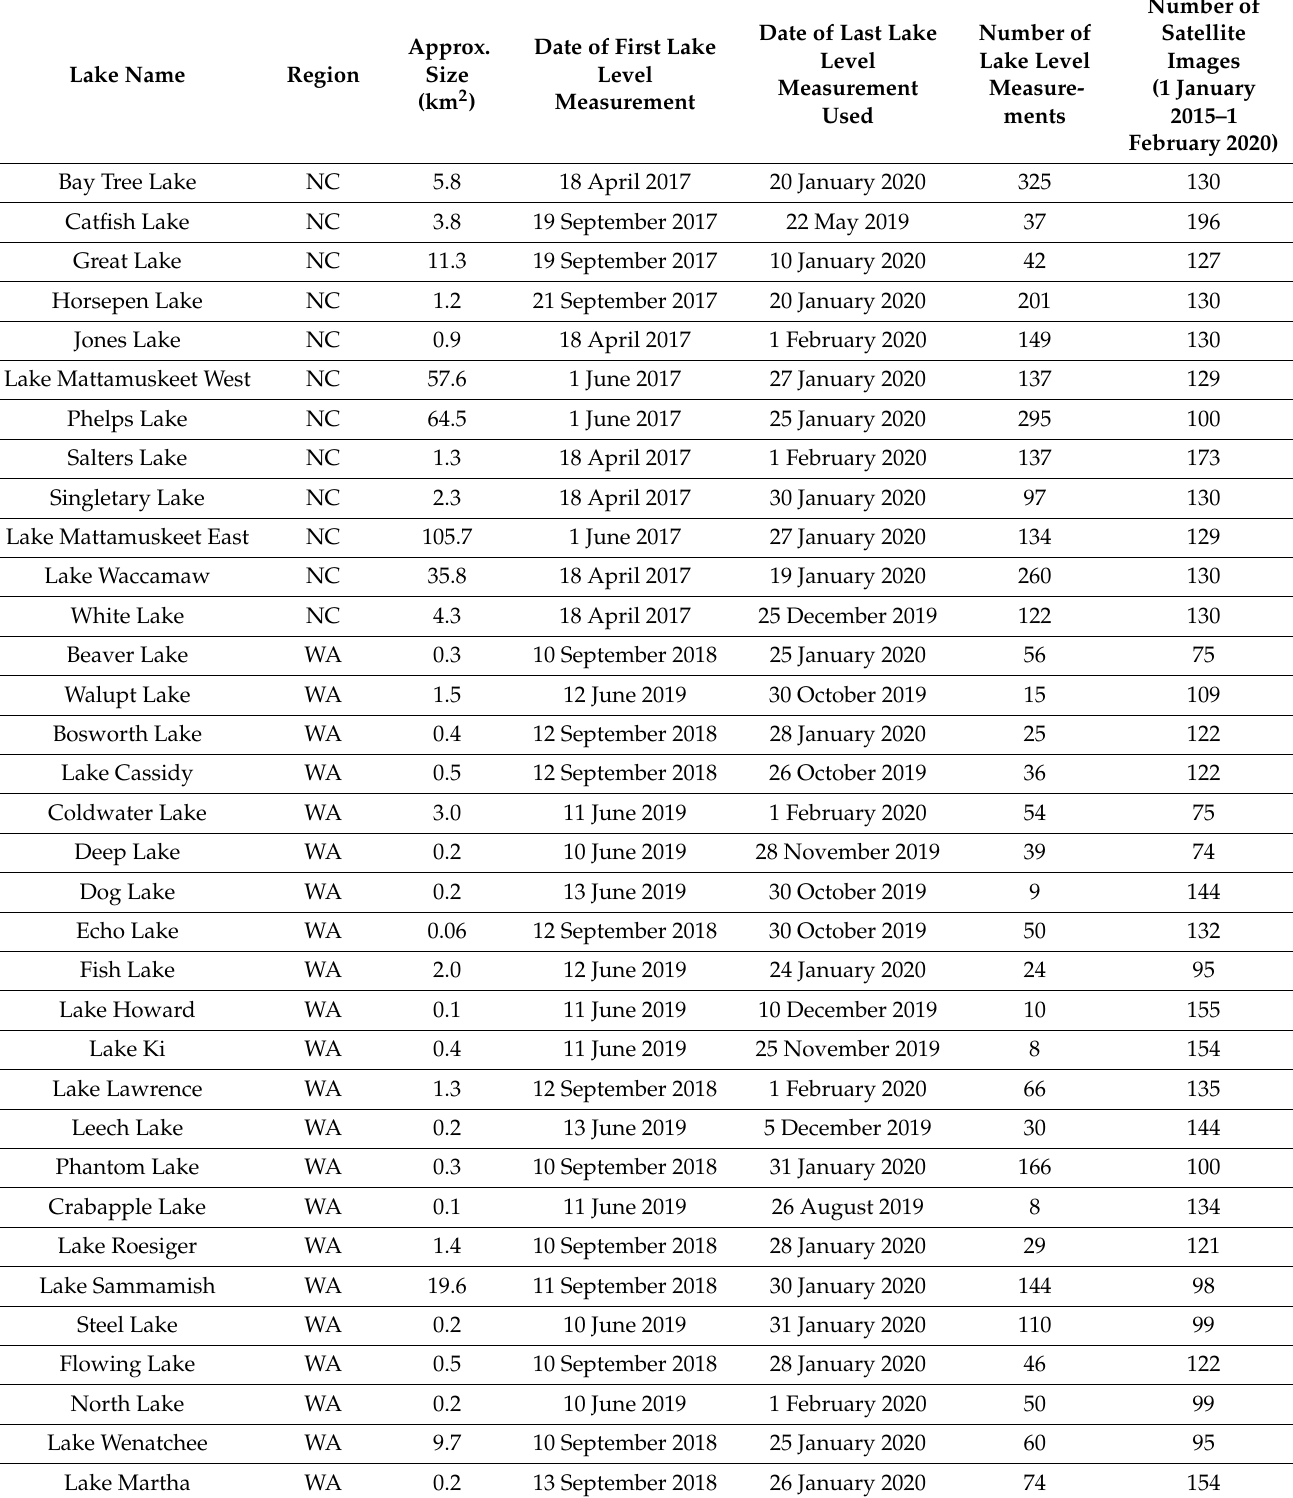
Table A1. Individual Lake